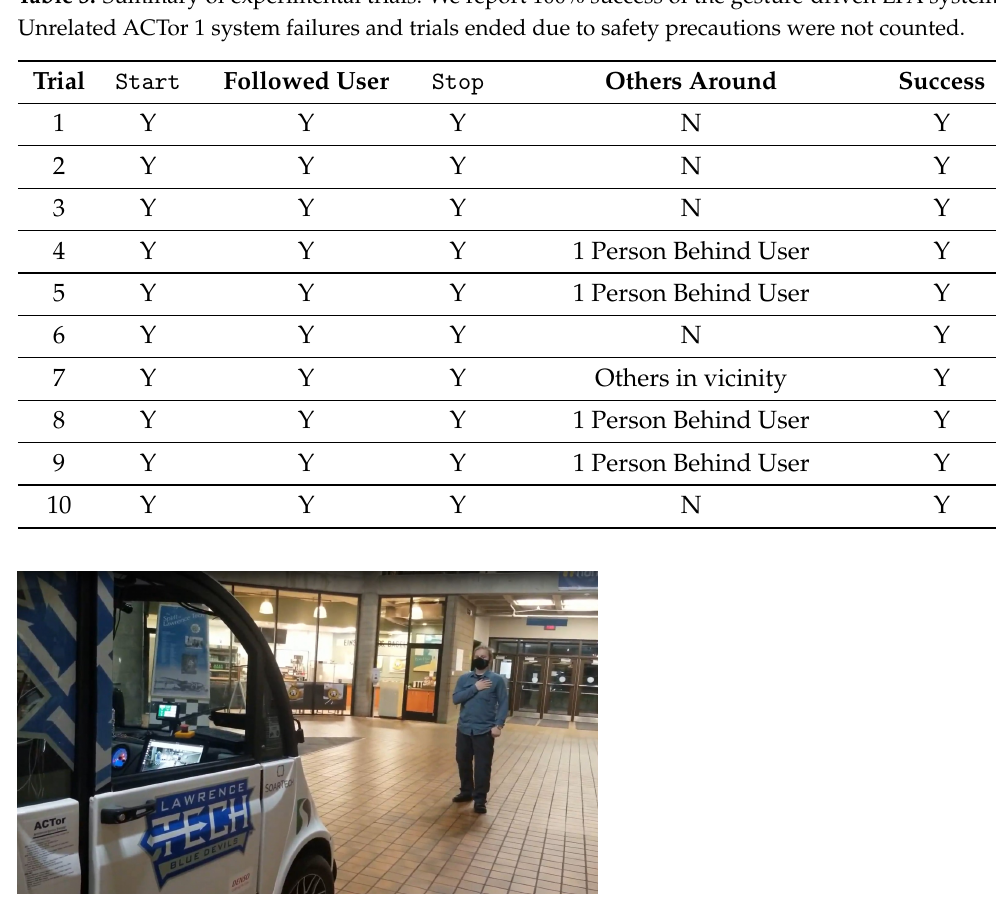
Figure 12. Author J. Schulte gives ACTor 1 the follow command. Author M. Kocherovsky sits in the driver’s seat as a safety precaution. Picture taken by author CJ Chung.